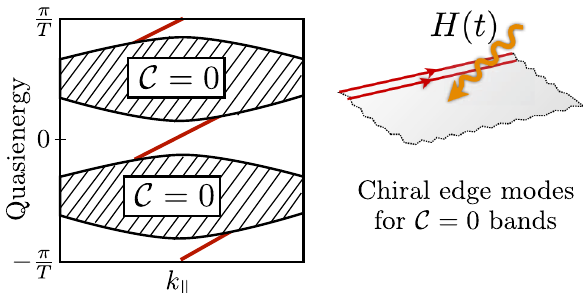
FIG. 1. Topologically protected Floquet edge modes in a two- band system with trivial Chern indices C ¼ 0 . This situation is made possible due to the periodicity of the quasienergy " : In addition to the edge modes that cross the gap near " ¼ 0 , a second branch of edge modes crosses through " ¼ (cid:1)=T , thus connecting the top of the upper Floquet band to the bottom of the lower Floquet band and closing the quasienergy cycle. The Chern numbers correctly yield the differences between the numbers of chiral modes above and below every band but cannot be used to uniquely determine the edge-state spectrum of a periodically driven